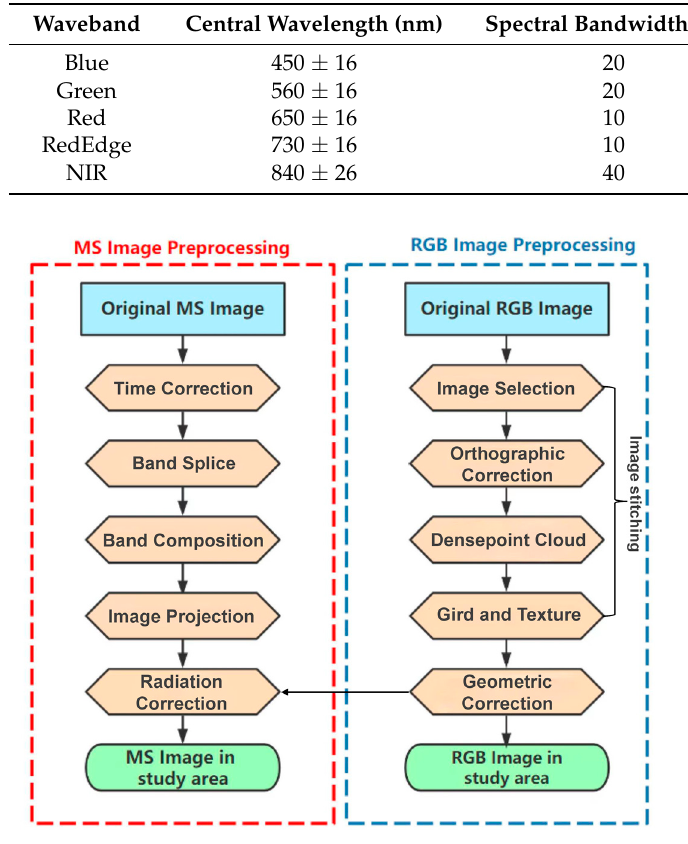
Figure 3. Pre-processing workflow of UAV